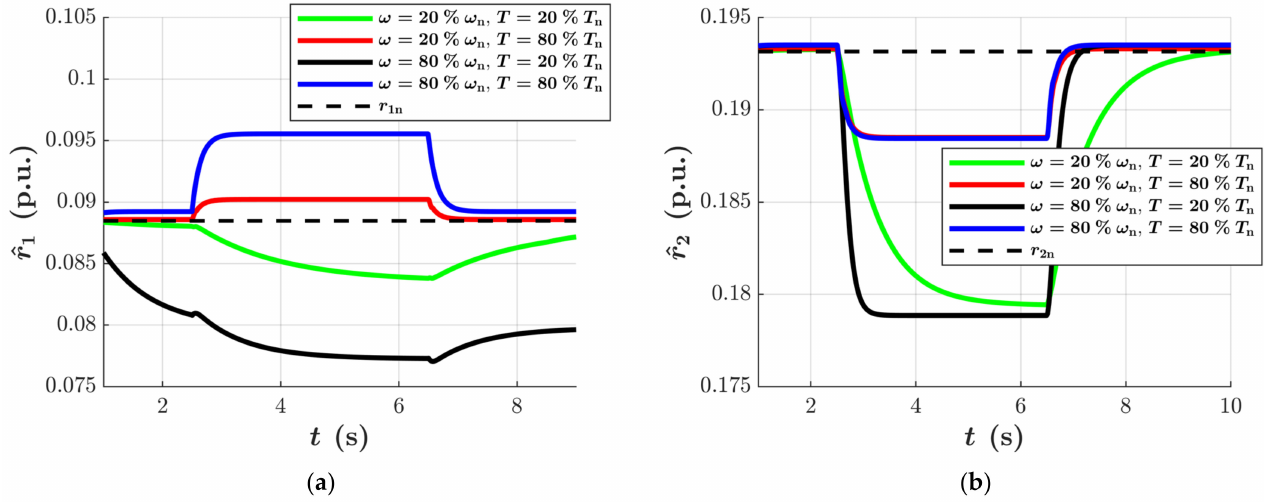
Figure 10. The effect of iron losses on the performance of MRAS-type estimators ( ω n denotes the nominal electrical rotor angular speed, T n denotes the nominal torque, and r 1 n and r 2 n are the nominal stator and rotor resistance, respectively). ( a ) P-MRAS for the stator resistance estimation; ( b ) Q-MRAS for the rotor resistance estimation. Compensation of iron losses in the FOC model deactivated at 2.5 s and activated again at 6.5